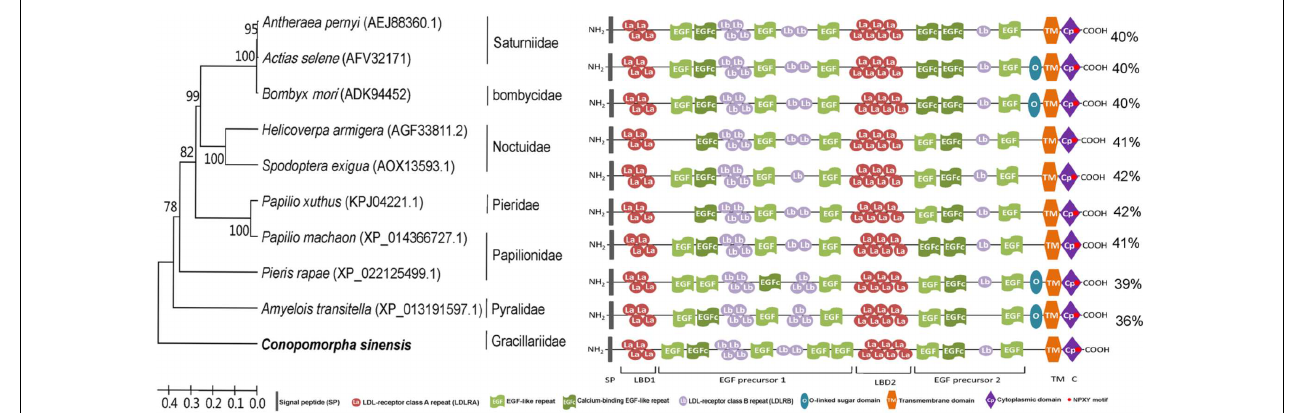
FIGURE 2 | Domain architecture and phylogenetic analysis of lepidopteran vitellogenin receptors (VgRs). The phylogenetic tree was constructed using sequences of different lepidoptera families. The C. sinensis sequence was used as an outlier, and the figure shows family grouping of the lepidopteran VgRs. The figure shows a comparable domain architecture in insect VgRs from different lepidoptera families. The percentages on the right indicate the overall identity of each protein compared to